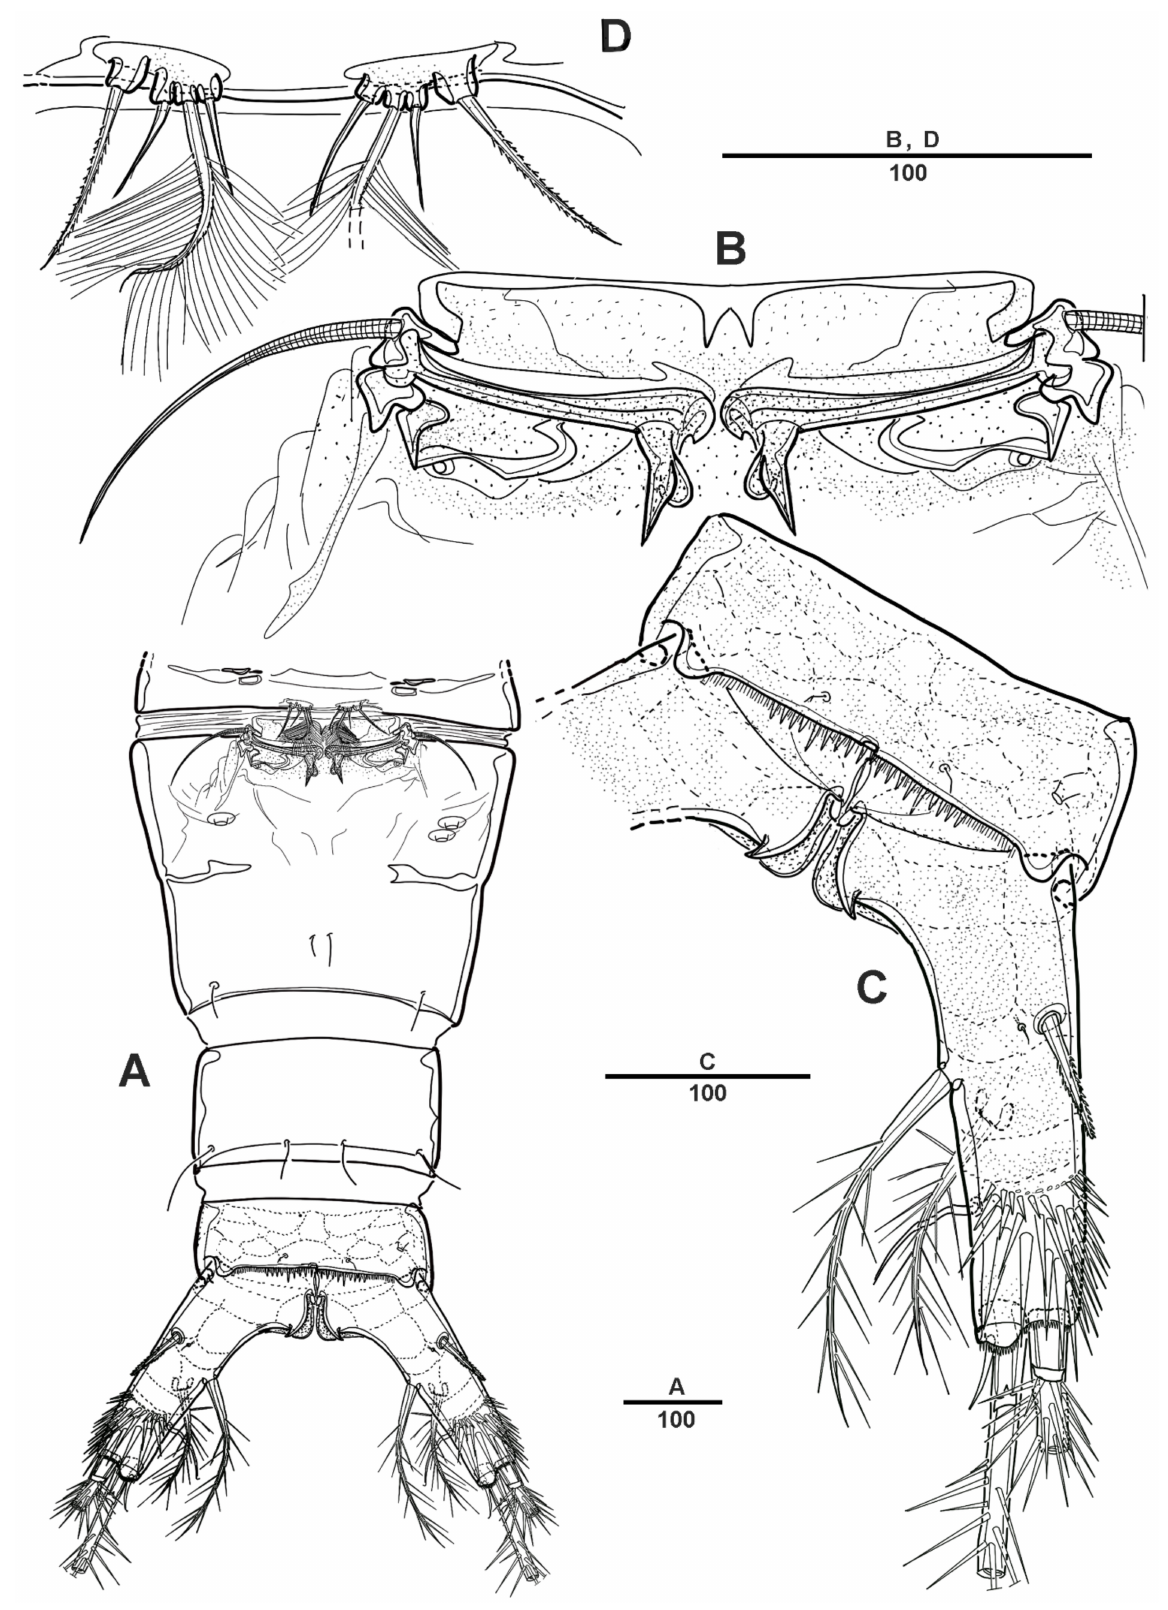
Figure 2. Scottolana daecheonensis sp. nov. holotype female: ( A ) urosome, ventral; ( B ) genital field, ventral; ( C ) anal somite and left caudal ramus, ventral; ( D ) P5. Scale bars in µ